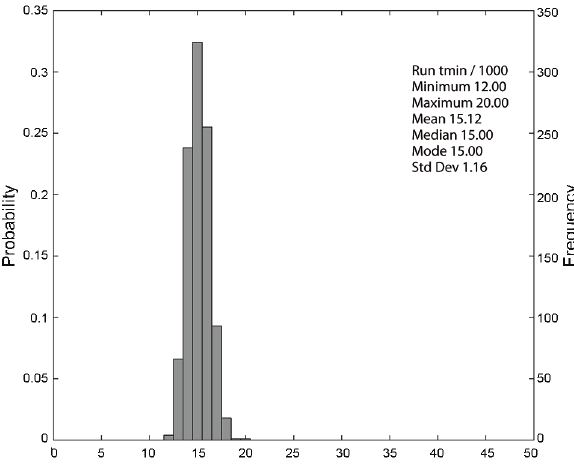
Figure 2. Probability distribution of the maximum value of Figure 1. Probability distribution of the minimum value of concession period ( max t concession period ( min